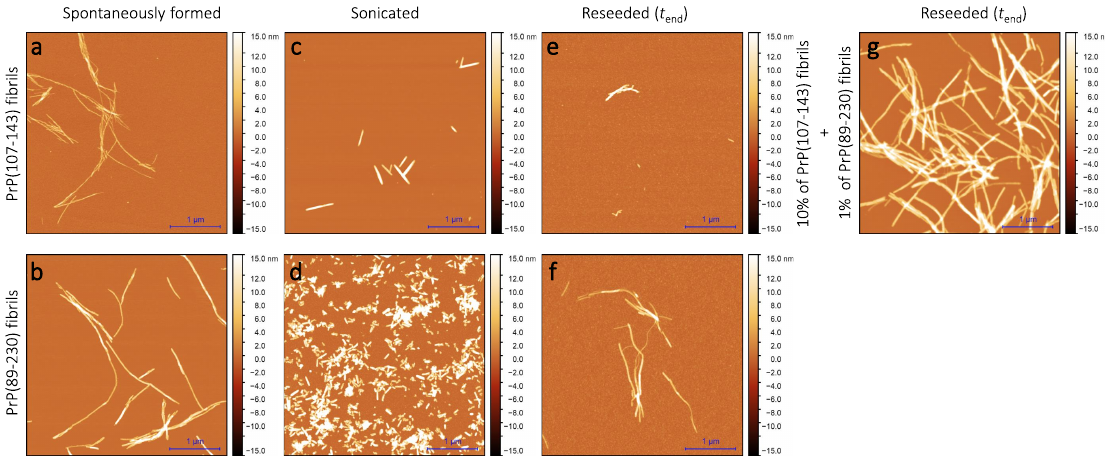
Figure 2. AFM images of PrP(107-143) and PrP(89-230) aggregates. Images of the spontaneously formed PrP(107-143) ( a ) and PrP(89-230) ( b ) aggregates. Images of sonicated PrP(107-143) ( c ) and PrP(89-230) ( d ) aggregates. Images of aggregates formed during PrP(107-143)-fibril-induced ( e ) or PrP(89-230)-seed-induced ( f ) aggregation reaction. Images of aggregates formed in the presence of both PrP(107-143)-fibrils and PrP(89-230)-seed ( g